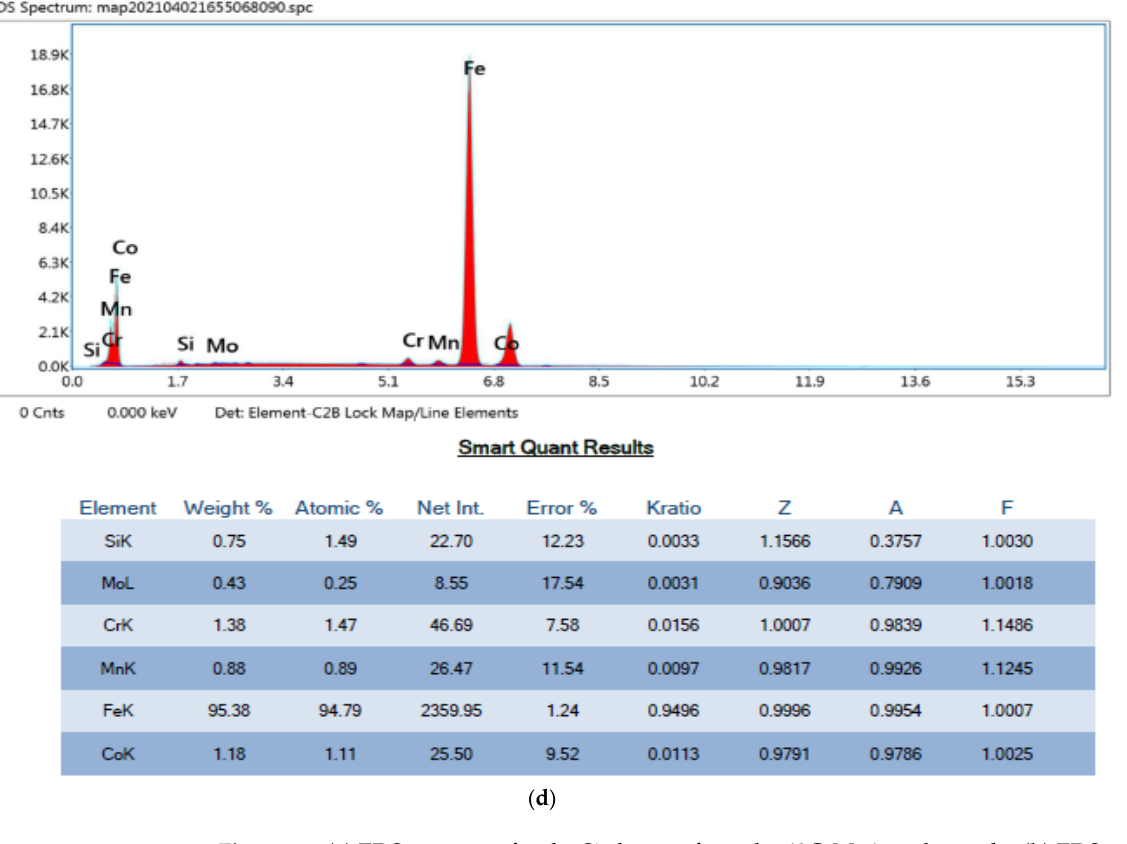
Figure 14. ( a ) EDS spectrum for the Si element from the 42CrMo4 steel sample. ( b ) EDS spectrum for the Cr element from the 42CrMo4 steel sample. ( c ) EDS spectrum for the Fe element from the 42CrMo4 steel sample. ( d ) The spot chemical analysis in the selected area for 42CrMo4sample.